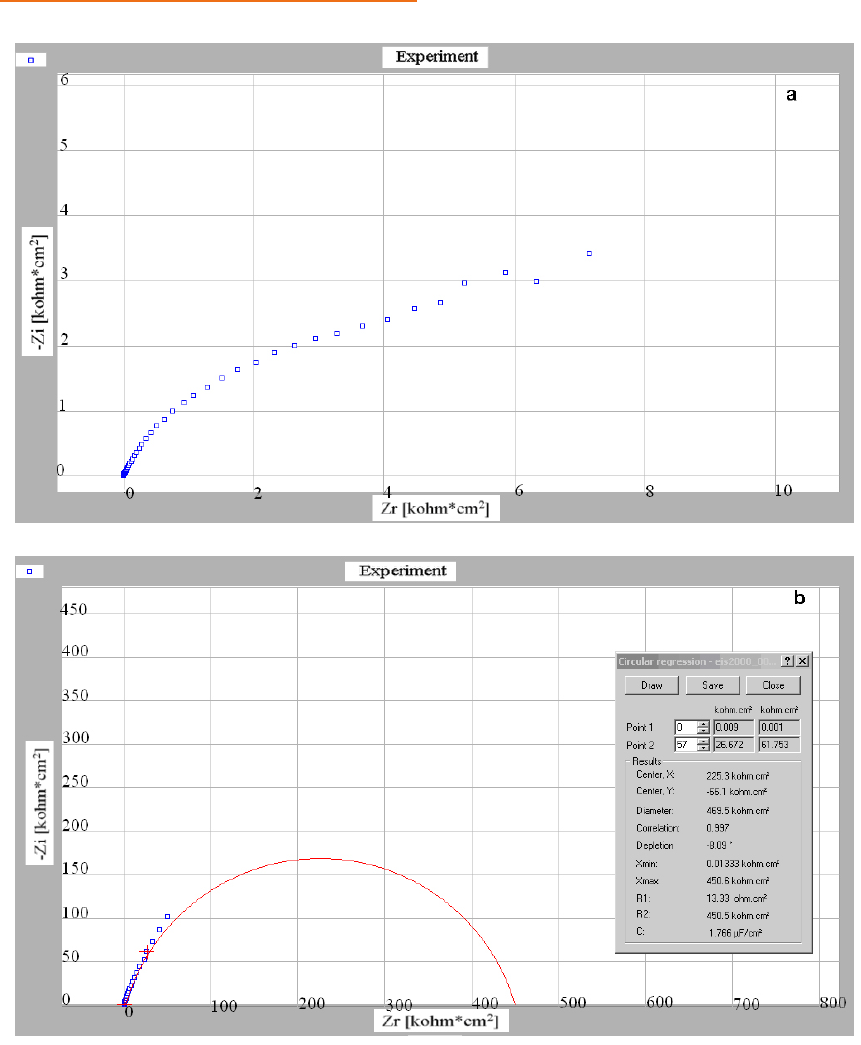
Figure 4. Screen capture of Nyquist diagrams for: a) sPEEK/PANi membrane – polystyrene sulfonic acid and b) sPEEK/PpPD membrane – polystyrene sulfonic